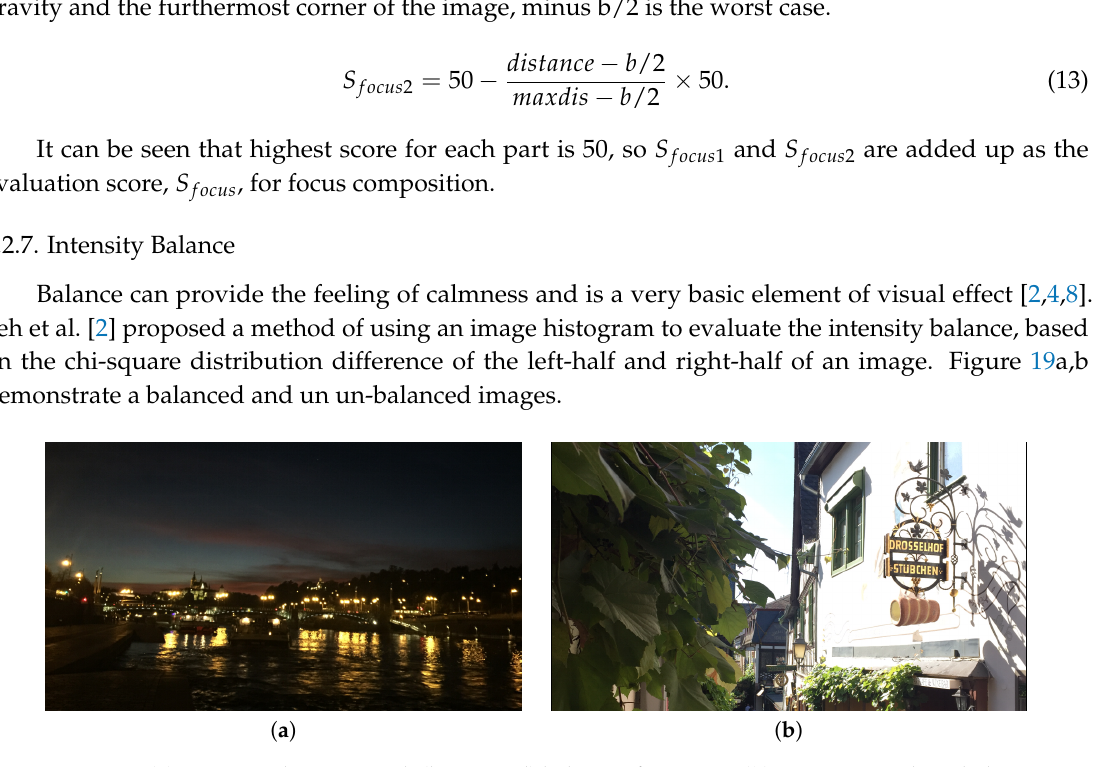
Figure 19. ( a ) An example image with (horizontal) balance of intensity. ( b ) An image without balance of